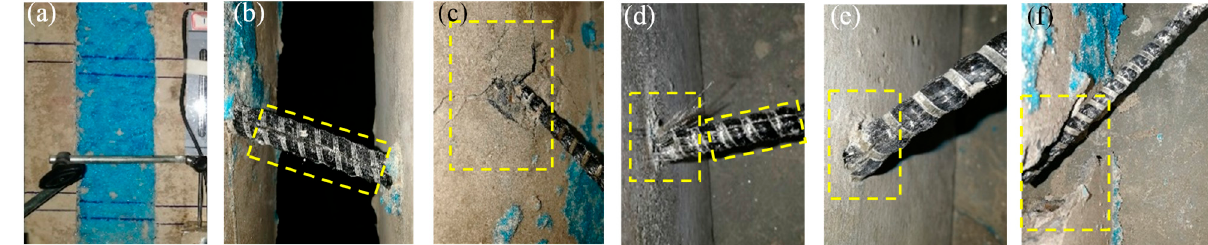
Figure 5. Failure modes ( a ) slippage; ( b ) inter-laminar failure; ( c ) concrete fracture; ( d ) inter-laminar failure and fiber fracture; ( e ) crack of connector; ( f ) concrete split.